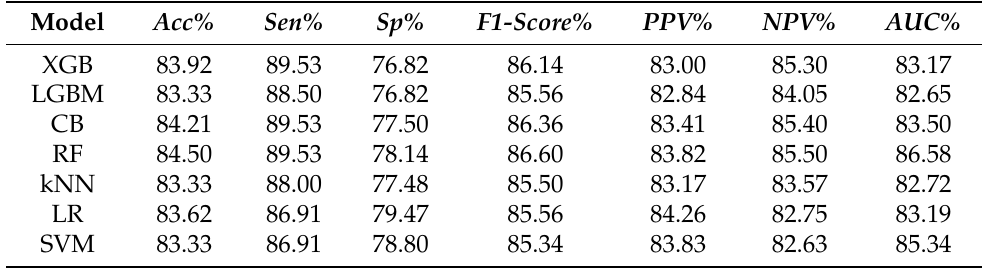
Table 4. Classification performance measures across ensemble and traditional models for 6 PSG features.